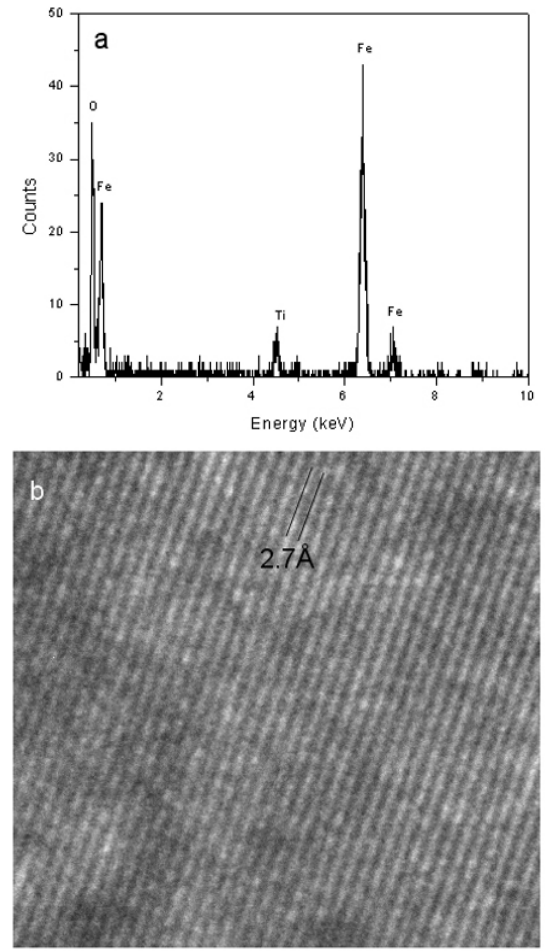
Figure 6. (a) TEM image of the Na